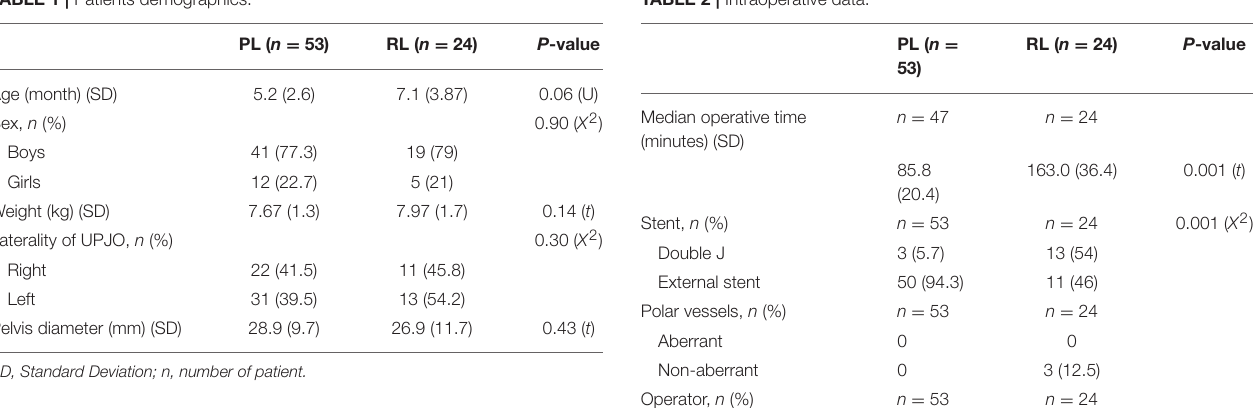
TABLE 1 | Patients demographics. TABLE 2 | Intraoperative